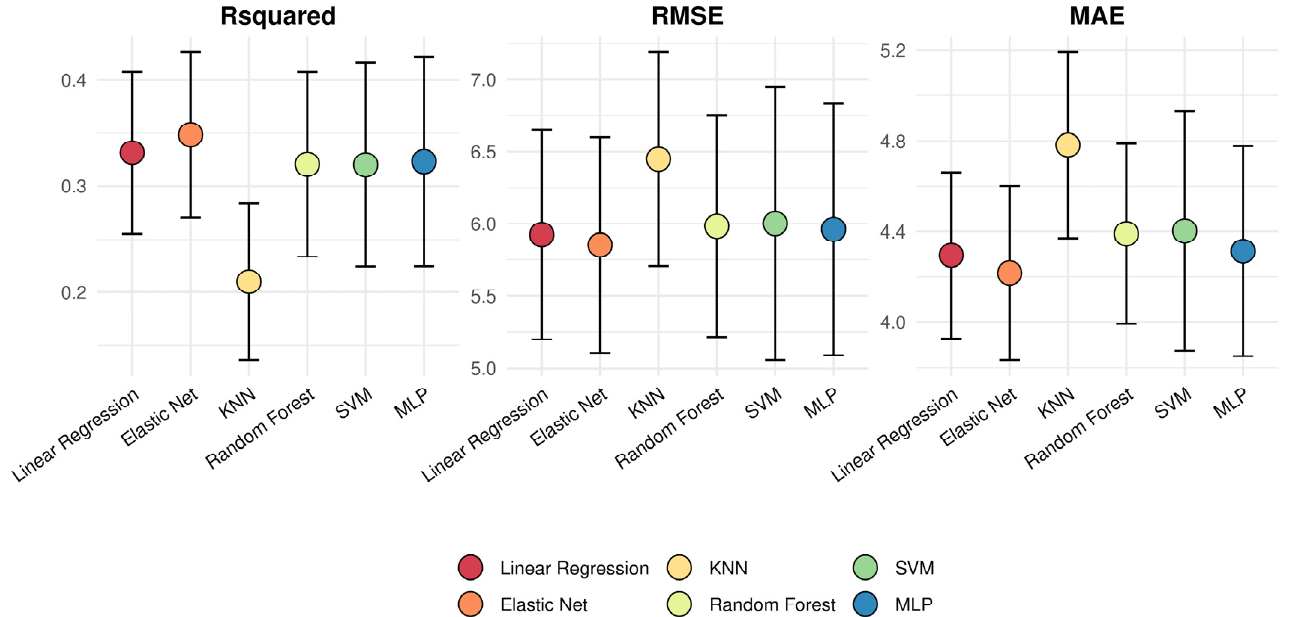
Figure 2. Variability in the performance of models’ training. In this plot, we show the variability in each metric of interest (R 2 , RMSE, and MAE) of the best model configuration obtained via 10-fold cross validation (5 repeats). Dots represent the average performance and error bars correspond to the standard deviation from each metric distribution. Keywords: MAE, mean absolute error; RMSE, root mean squared error; KNN, K nearest neighbors; SVM, support vector machine; MLP, multilayer perceptron.